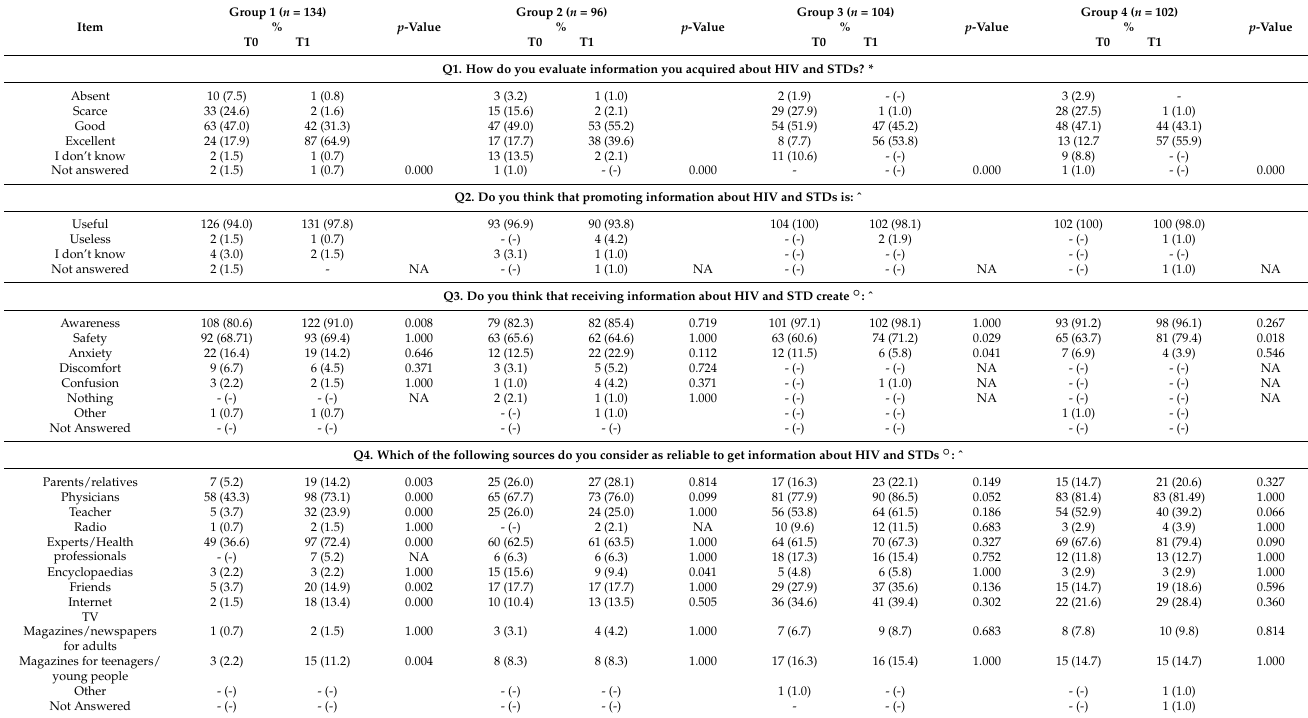
Table 3. Information needs about HIV and STDs before (T0) and after (T1) the educational